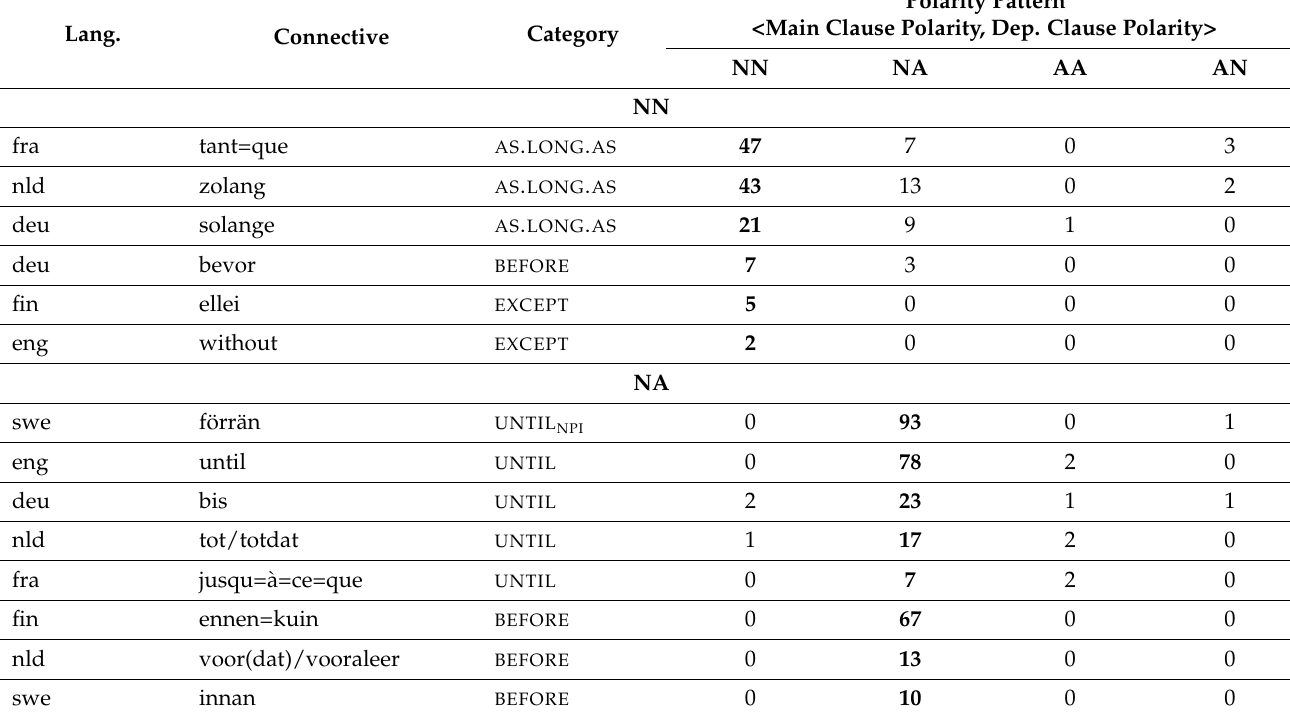
Table 5. Polarity patterns for